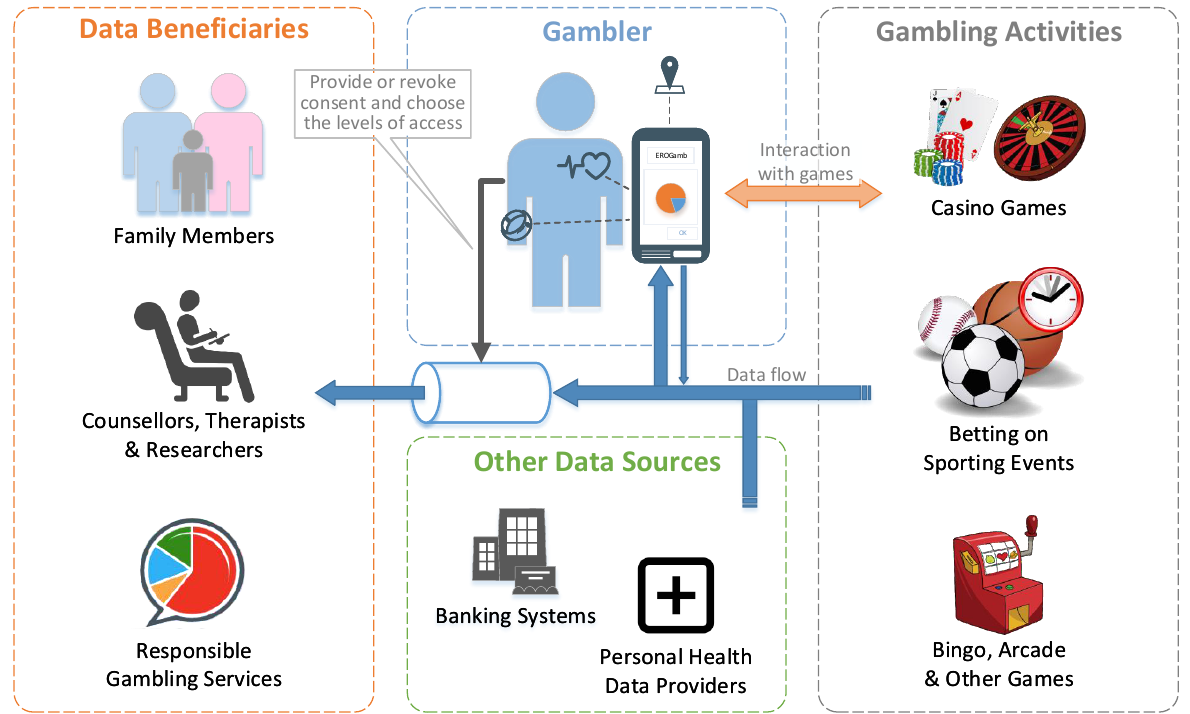
Figure 2. The data flow of gamblers to